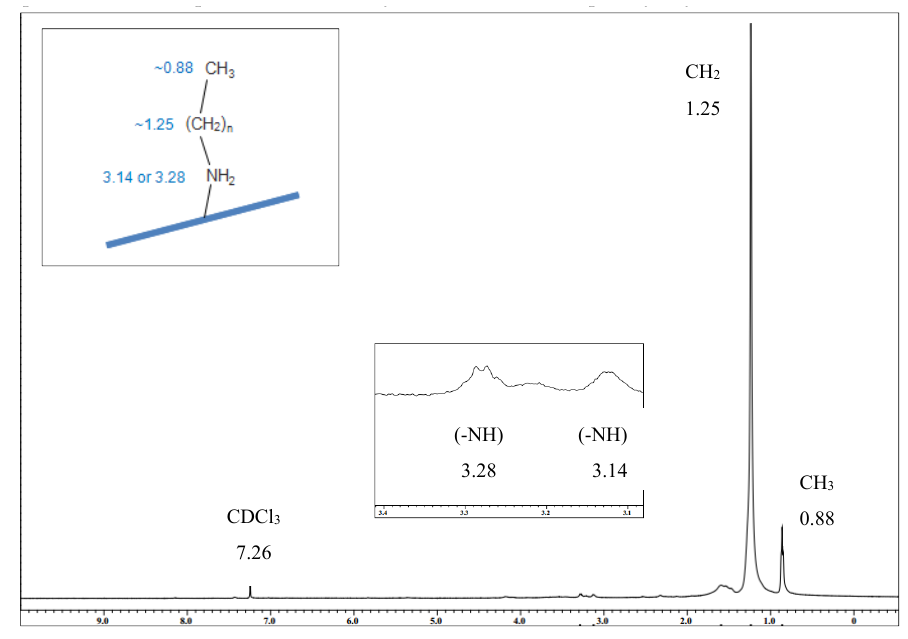
Figure 4. 1 H NMR spectrum of GO–A18 in CDCl 3 .